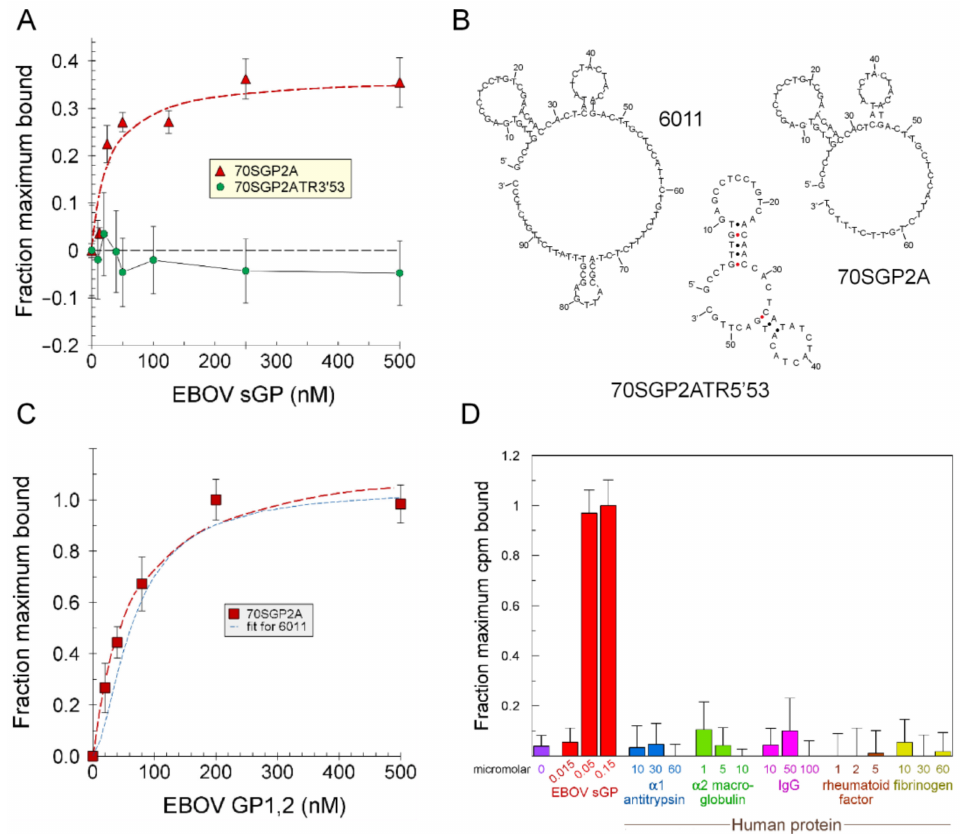
Figure 3. Activities of 6011 truncations . ( A ) Binding of 70SGP2A and 70SGP2ATR5 (cid:48) 53 to EBOV sGP at the concentrations identified by the x-axis labels. ( B ) Predicted 2D structures of 6011, 70SGP2A, and 70SGP2ATR5 (cid:48) 53, ( C ) Binding of 70SGP2A to EBOV GP1,2. The blue dotted line is the fit line from Figure 2C for the binding isotherm of 6011 with GP1,2. ( D ) The specificity of 70SGP2A for sGP and GP1,2 was tested with 32 P-70SGP2A incubated with the identified concentrations of each protein. The amount of 32 P-70SGP2A bound to protein was determined by filter capture for each condition. Cpm bound for duplicates for each condition were averaged, and the averages of blanks (no protein) were subtracted from values of samples with protein. The average cpm (-blank) bound for each condition was normalized to the average cpm (-blank) bound by 0.15 µ M sGP. In each titration, the concentrations of the proteins are for the quaternary structures, which are the sGP homodimer, the IgG heterotetramer, and monomers for the other listed proteins. All binding assays were performed in PBS at 23 ◦ C. Standard deviations were calculated as described in materials and methods to include the error in the blank when that was